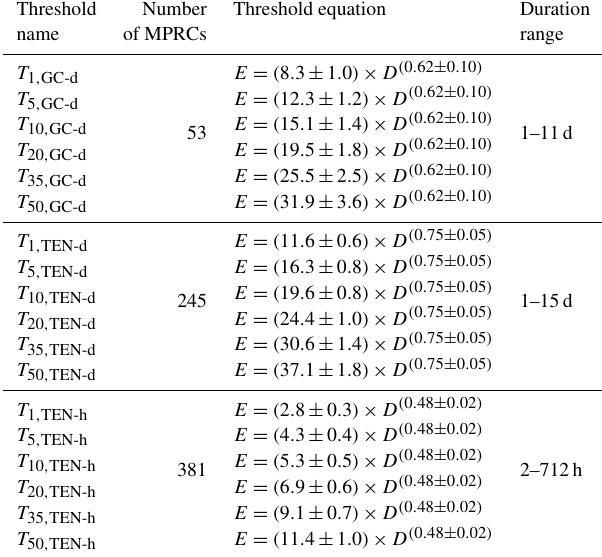
Table 3. ED rainfall thresholds at different nonexceedance prob- abilities (1%, 5%, 10%, 20%, 35%, and 50%) for the GC and TEN test sites. The number of MPRCs and the duration range of each threshold are also reported.